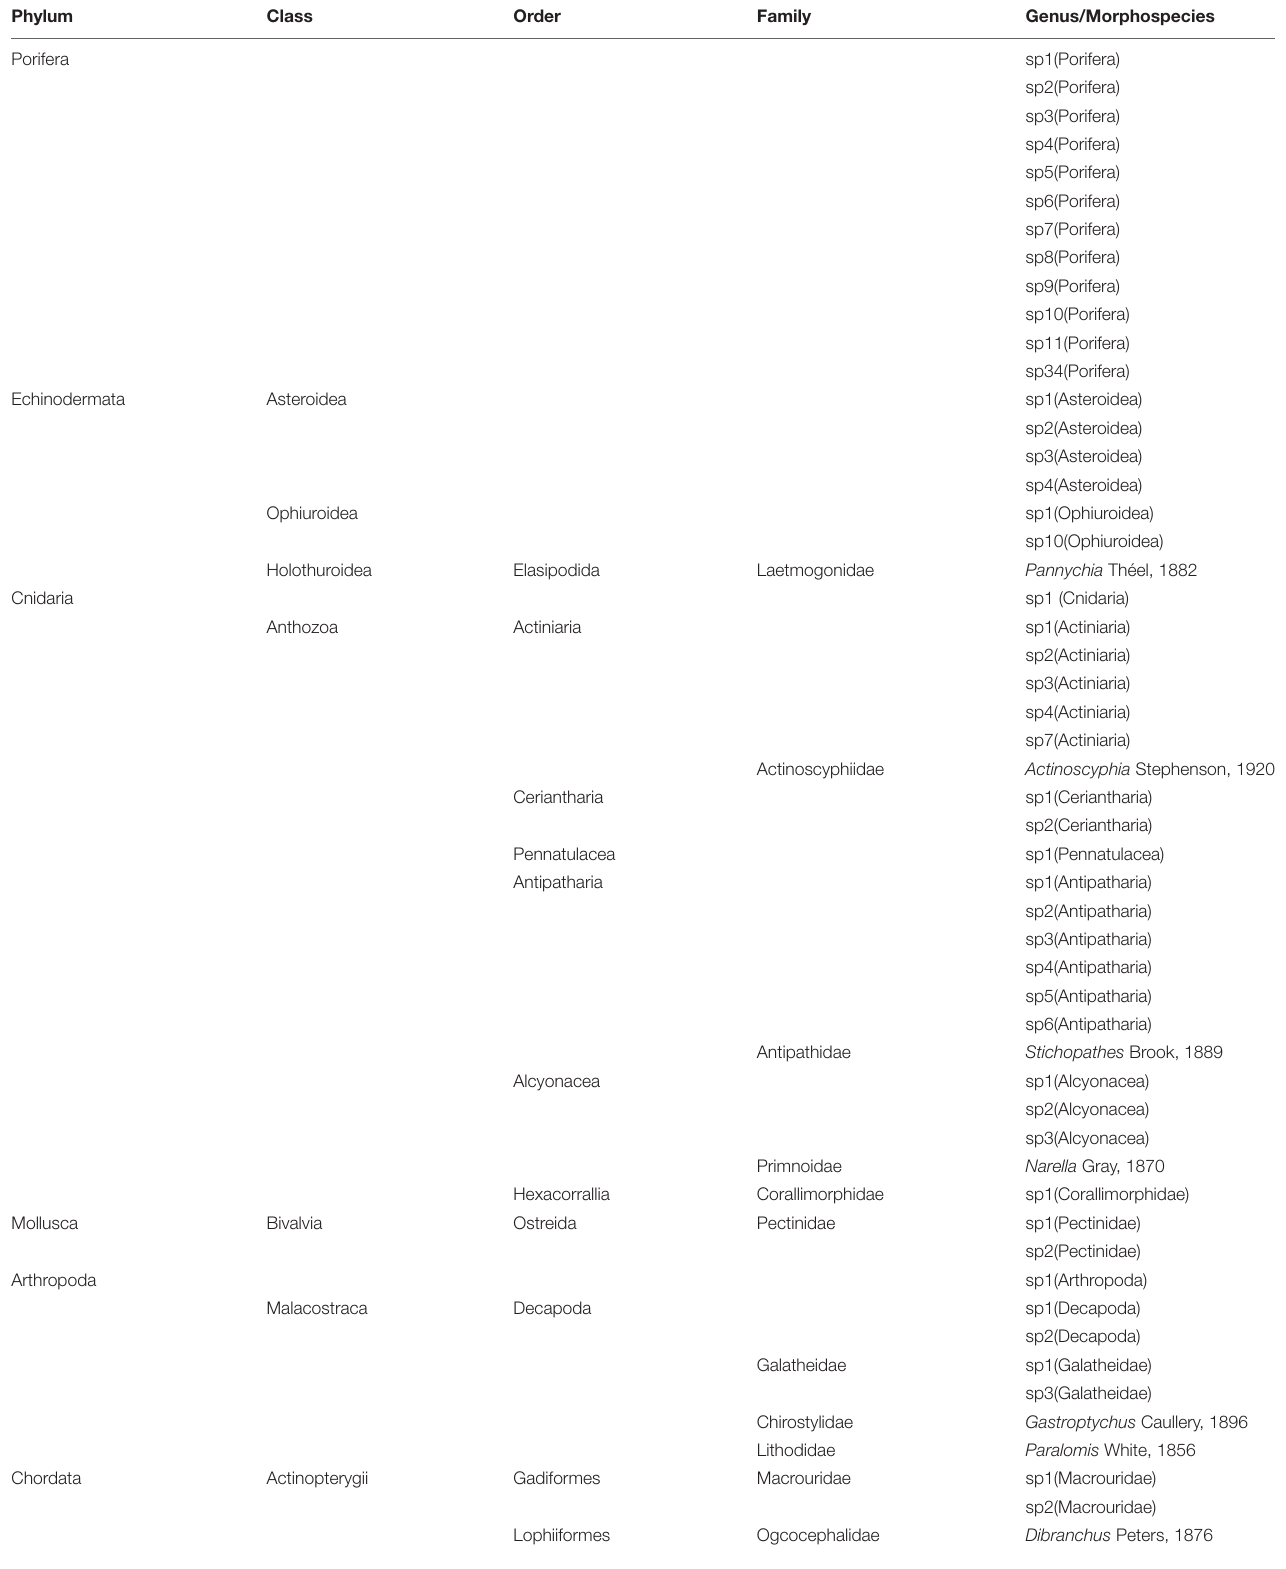
TABLE 2 | Taxonomic list in the NW limit of Guaymas Basin and the Sonoran Margin (849–990 m) inhabiting soft and hard substrate.